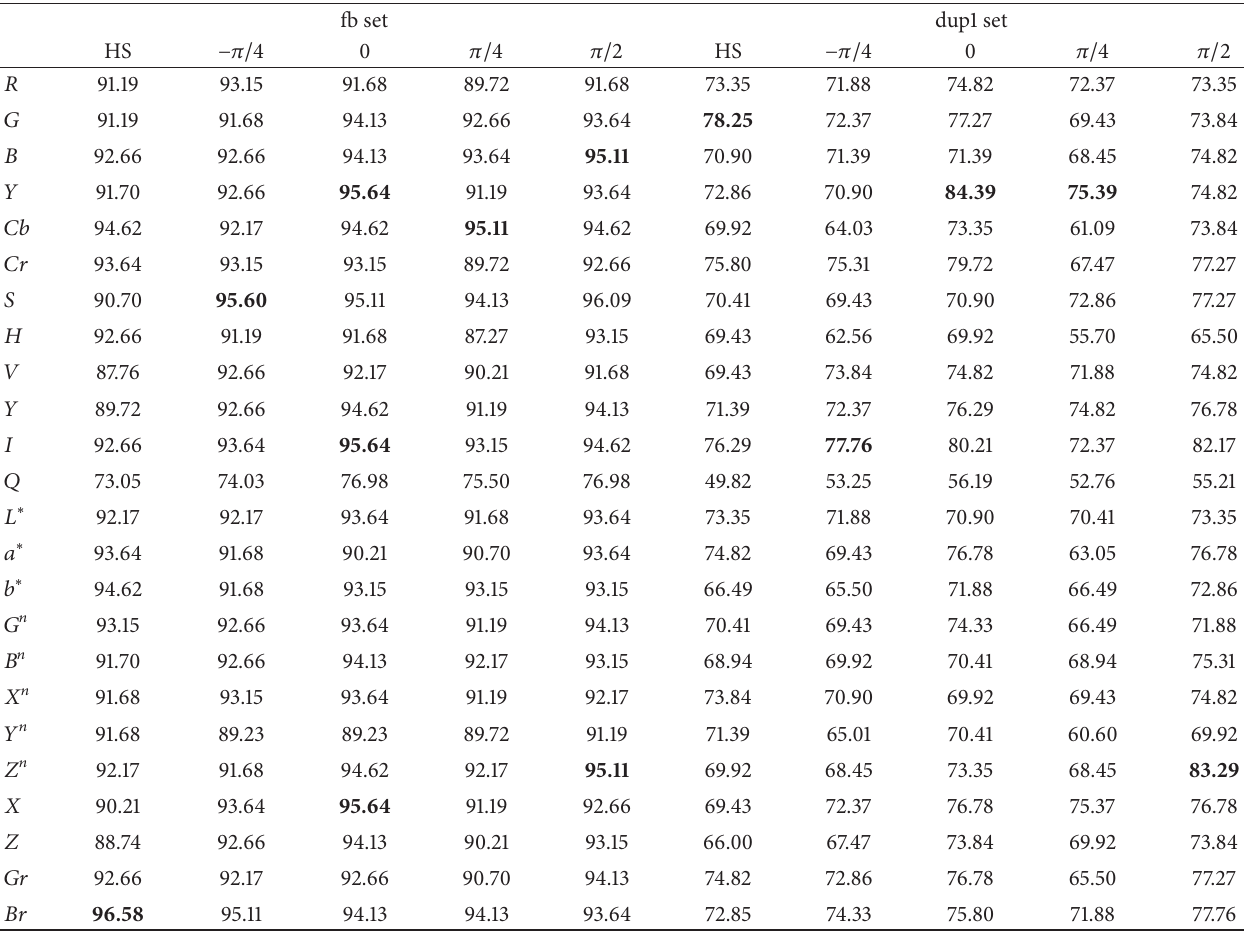
Table 5: Performance comparison in the color component images of LCSPT-ELM face recognition algorithm: the color FERET database.